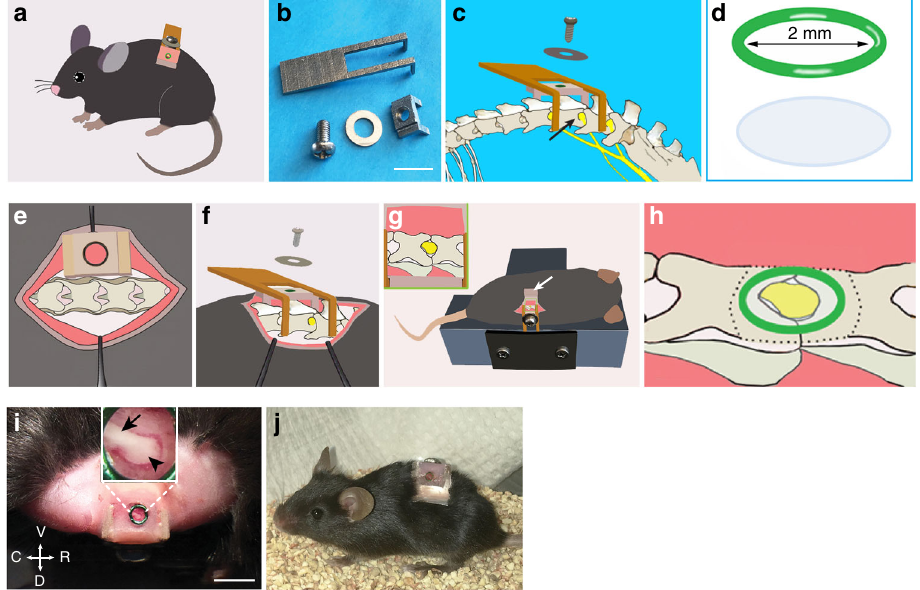
Fig. 1 A vertebral window allowing DRG imaging in awake mice. a Schematic showing a mouse with an implanted DRG imaging window. b Components of the vertebral mount: two L-shaped mounting plates, one screw and one screw washer. Scale bar, 10 mm. c Schematic showing the assembly of the vertebral mount along L4 and L5 vertebrae, just above the iliac crest. L3 – 5 DRGs and spinal nerves were depicted in yellow. Arrow indicates L4 DRG. d Imaging window was made of a 2-mm diameter coverslip and aluminum ring (green). e Prongs of the short plate were aligned to the vertebral column on the opposite side of the targeted DRG. f Prongs of the long plate were positioned to the same side of the targeted DRG. Two plates were registered with a screw and a washer. g L4 DRG exposure. The mouse was positioned lying on its right side with the vertebral mount secured to a metal base. Arrow indicates the aluminum sheet used to retract lateral muscle. The inset shows the targeted DRG and the surrounding vertebral bone. h The articular processes surrounding the DRG was trimmed before the glass window (green circle) was placed on top of the DRG. Dotted line indicates the trimmed area. i Photograph showing the DRG window mounted in place with dental cement. The inset shows a zoom-in view of L4 DRG, ready for two-photon imaging. Arrow head points to DRG; arrow points to spinal nerve. C: caudal; R: rostral; D: dorsal; V: ventral. Scale bar, 5 mm. j Photograph showing a mouse with